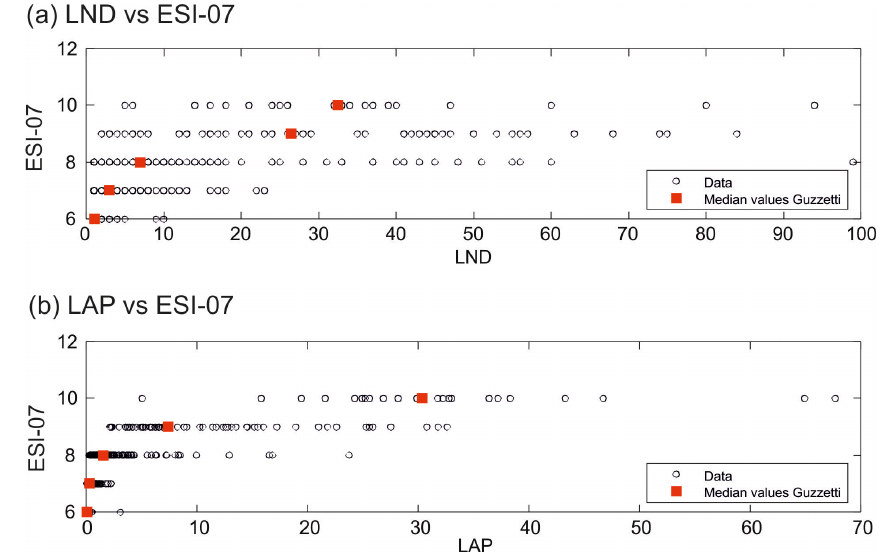
Figure 8. Plots of LND (a) and LAP (b) vs. local ESI-07; intensity computed using the Guzzetti et al. (2009) scaling relation is shown as an example. Table 4. Median values of LAP (%) for each ESI-07 intensity degree, obtained using the area–volume scaling relations of Table 1.